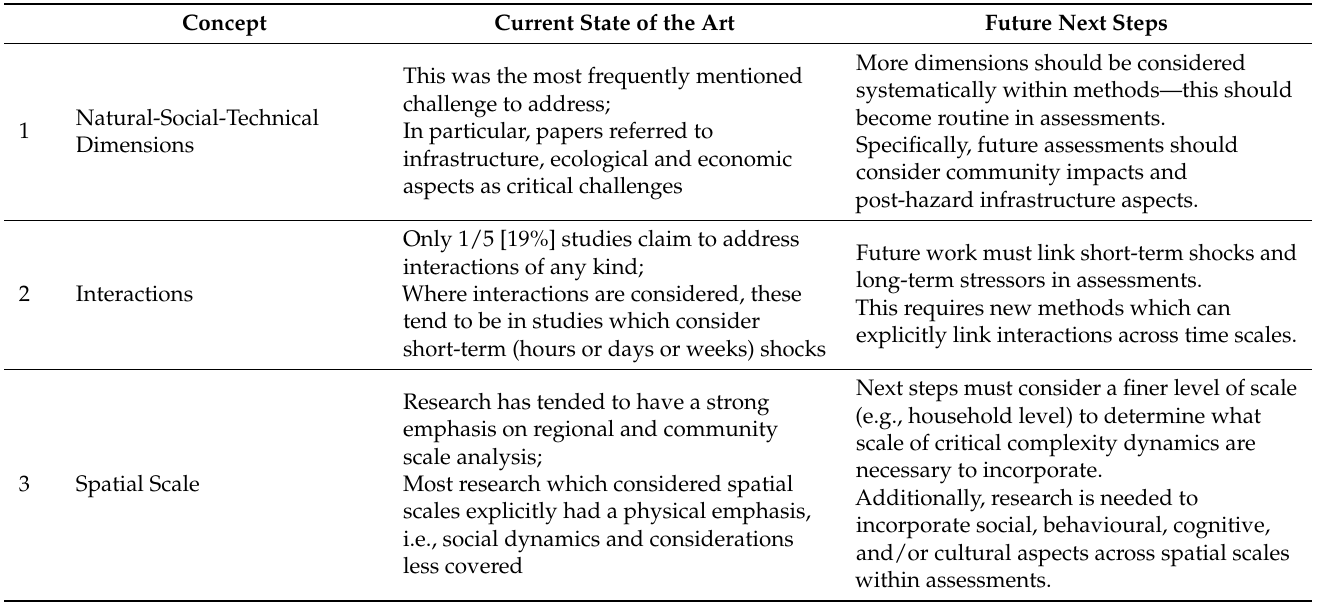
Table 1. Next steps for studying complex catchment systems, respective to key complexity